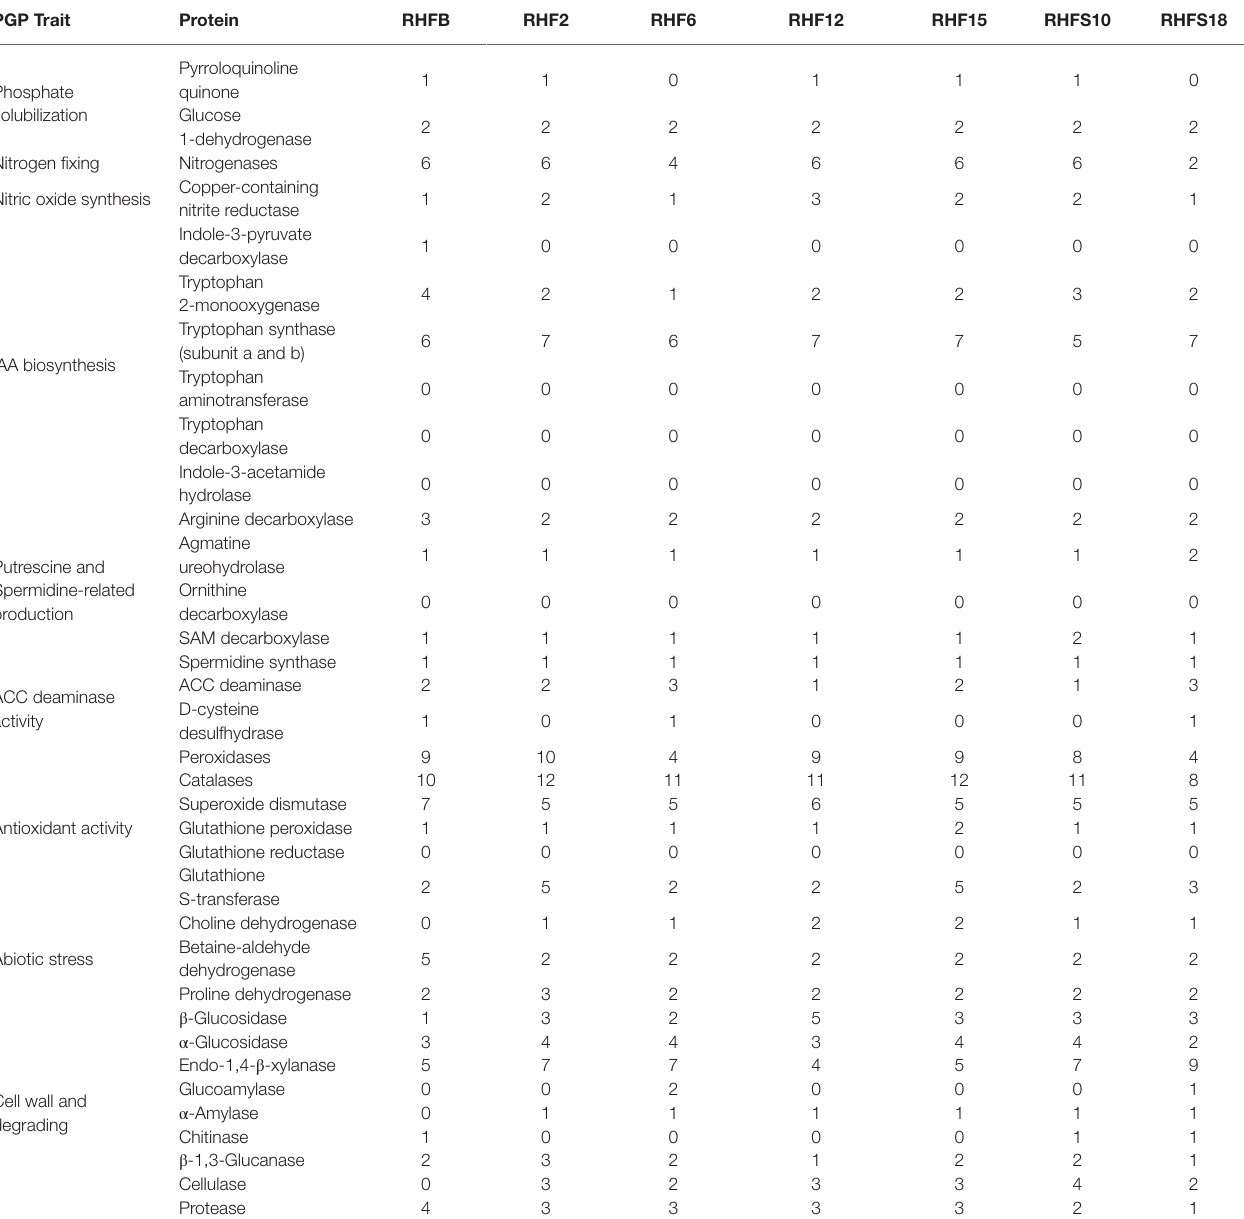
TABLE 5 | Plant-Growth-Promoting traits-associated proteins identified in the proteome of the selected strains and their